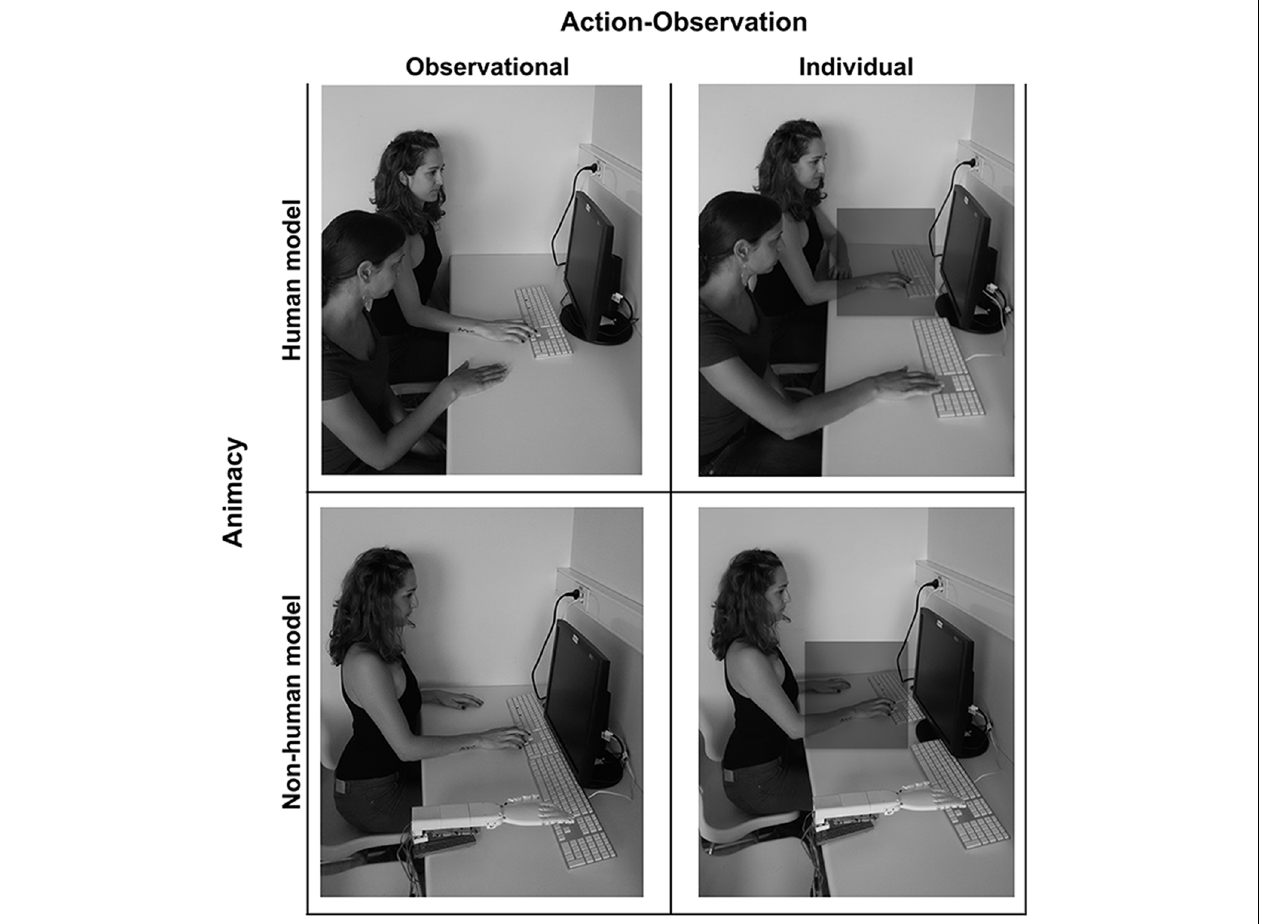
FIGURE 2 | 2 × 2 factorial design with the factors of animacy (human/robot model) and action-observation (observational/individual). See Figure 1C for